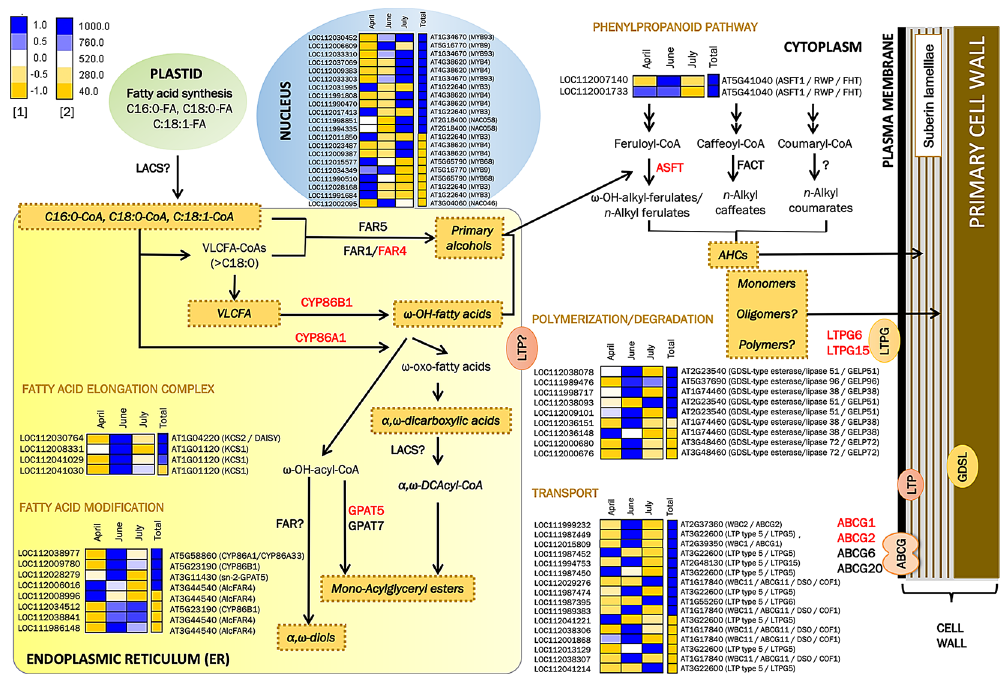
Figure 2. Expression pattern along the cork growing season of genes involved in suberin-related processes. For each gene, the relative expression pattern (April, June and July) 1 and the total expression 2 of normalized read counts are shown as a heatmap, in which blue and yellow colours represent high and low expression values, respectively. The genes with demonstrated function identified in the cork transcriptome are highlighted in